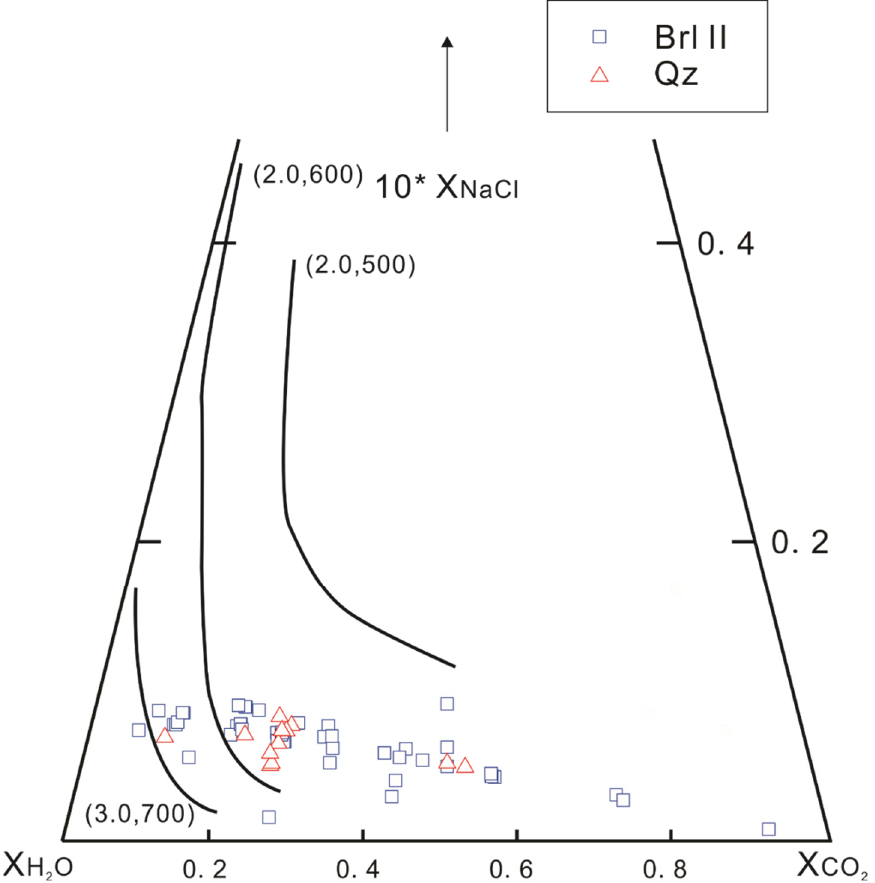
Figure 12. CO 2 -H 2 O-10×NaCl ternary (mole fraction) with Dakalasu No.1 pegmatite (beryl II and quartz) type 2 inclusions trapped in the one-fluid phase region, shown by the shaded area. Note that the diagram is stretched along the vertical axis (after [35]). Thick curves represent isothermal-isobaric projections of the solvi bracketed in experiments of Frantz et al. [59], shown as half-filled squares. P in kbar and T in °C for the solvus lines and for selected experiments are shown in parentheses.